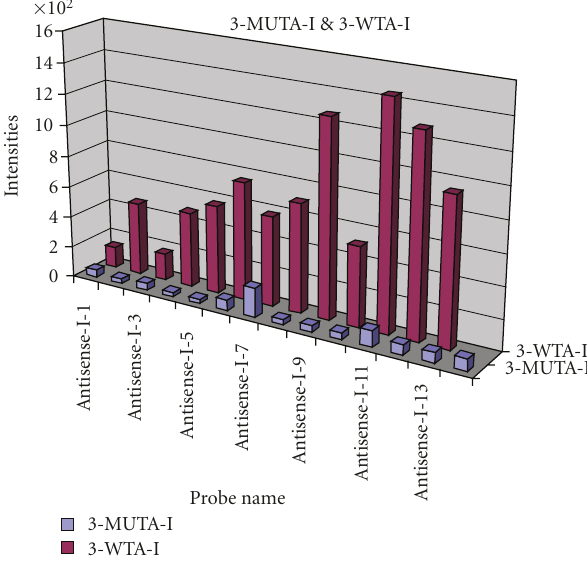
Figure 9: Data analysis results of mutation 3 (antisense strand), by the emulated architecture for wild type hybridization.